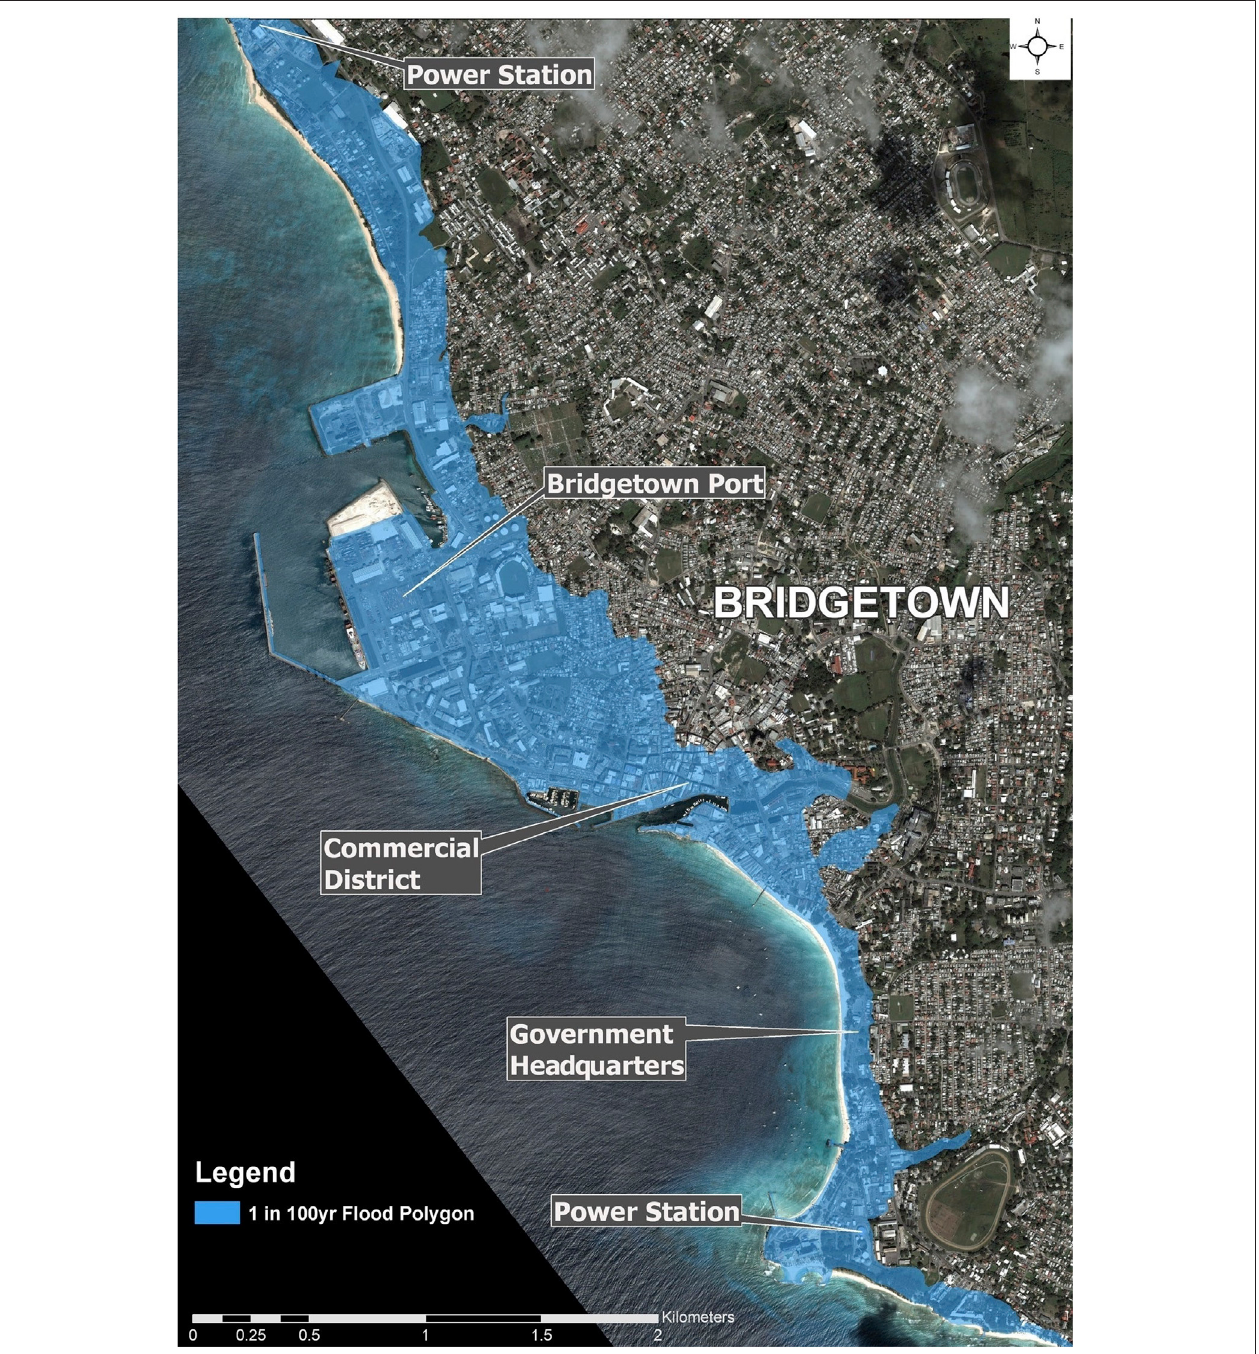
FIGURE 4 | Flood hazard map of Bridgetown showing some of the key coastal assets (Coastal Zone Management Unit, Government of Barbados).